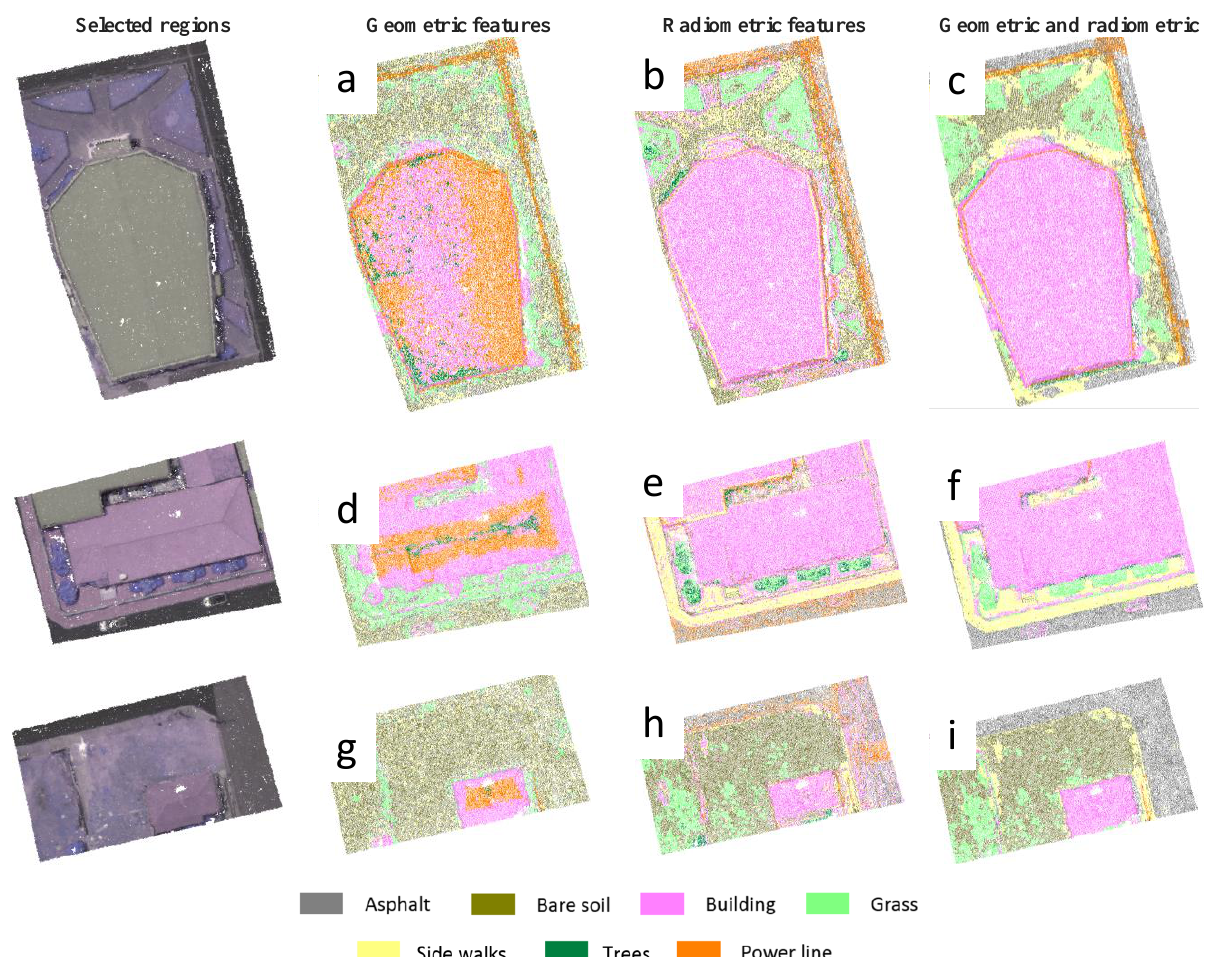
Figure 5. Classification results for the three selected regions considering different